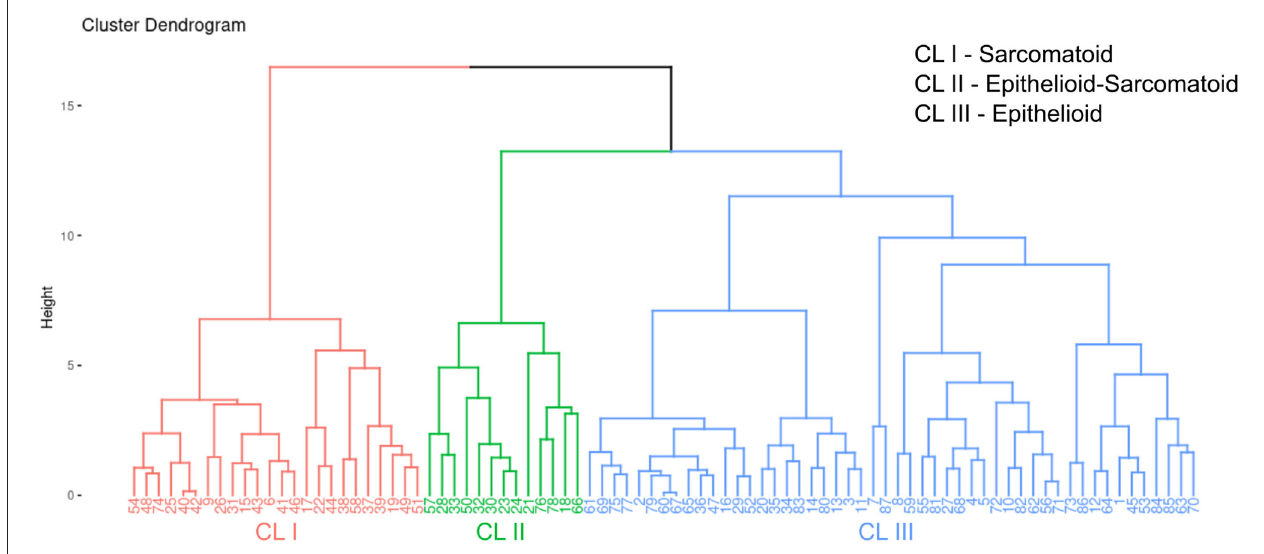
FIGURE 5 | A dendrogram of clusters with three distinct groups split by dispersion similarities in our MM